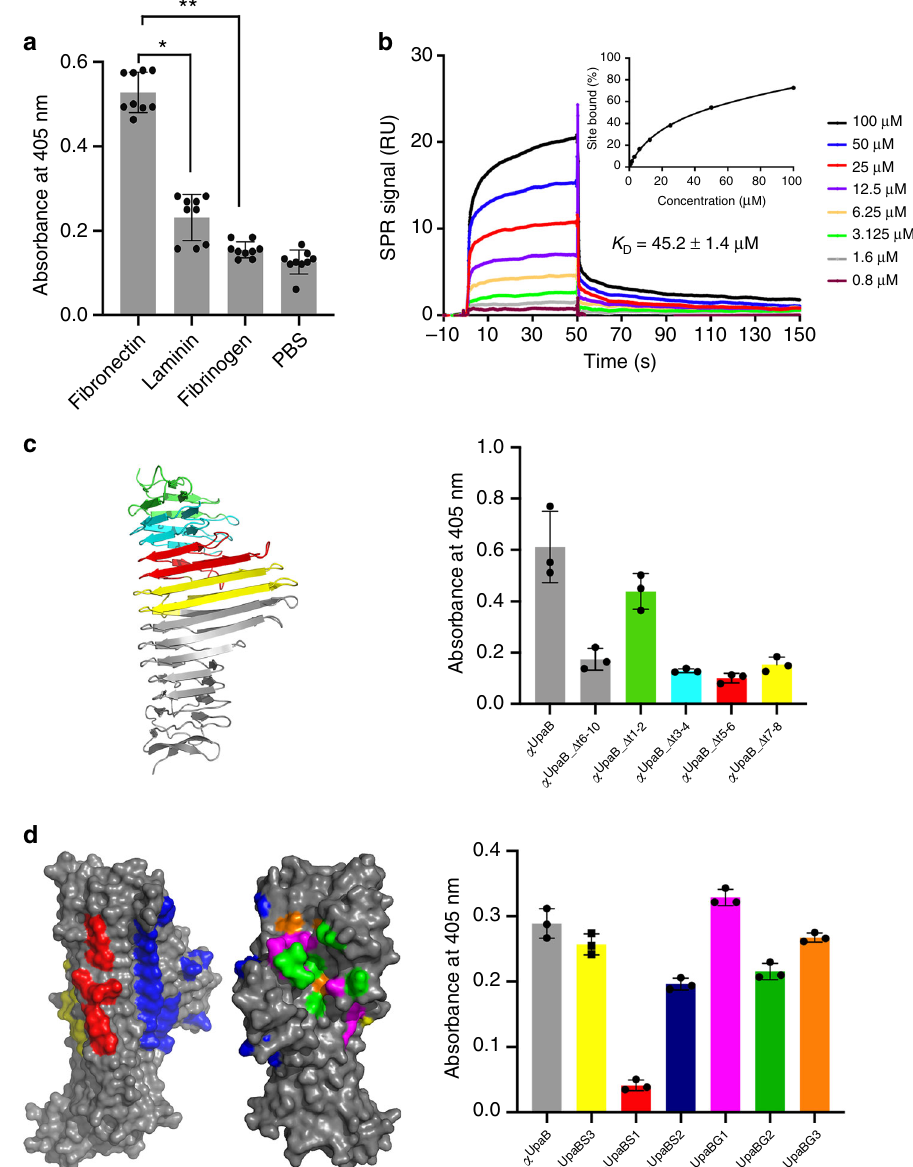
Fig. 3 Functional analysis of the UpaB fi bronectin-binding site. a Assessment of UpaB binding to human fi bronectin, laminin and fi brinogen by enzyme- linked immunosorbent assay (ELISA) using a UpaB-speci fi c polyclonal antibody. UpaB showed highest af fi nity towards fi bronectin. Statistical signi fi cance was determined by unpaired two-sample t test, * P < 0.001, n = 9; ** P < 0.001, n = 9. b Surface plasmon resonance analysis of α UpaB binding to immobilised fi bronectin. A series of concentrations (0.8 – 100 µ M) of α UpaB , as indicated in the sensogram, were injected over fi bronectin. The apparent equilibrium dissociation constant K D was determined using a steady-state af fi nity model. The data are expressed as mean ± standard error of the mean (SEM) of three replicates. c Assessment of binding to fi bronectin by UpaB deletion mutants; α UpaB- Δ t6 – 10 (grey); α UpaB- Δ t1 – 2 (green), α UpaB- Δ t3 – 4 (cyan), α UpaB- Δ t5 – 6 (red) and α UpaB - Δ t7 – 8 (yellow) using ELISA and a fi bronectin-speci fi c polyclonal antibody. α UpaB (native) was included as control. Data are shown as the means ± standard deviation of three replicates. d Assessment of binding to fi bronectin by UpaB mutants containing targeted amino acid substitutions using ELISA and a fi bronectin-speci fi c polyclonal antibody. Targeted changes were made to various surface features of UpaB including an acidic patch α UpaB_S1 (red; N116A, D119A, N146A, N175A, D217A, K245A, D246A, D281A, R310A and D336A) and polar patch α UpaB_S2 (blue; N110A, K111A, N112A, D142A, N171A, D206A, D208A, N212A, N241A, N274A, N276A, N303A, N305A, K325A, D329A, D331A and D349A) on the F2 face, a hydrophobic patch α UpaB_S3 (yellow; V151A, I221A, V249A, A252G, A253G, Y285A, Y312A and V339A) between the F2 and F3 faces, along with a hydrophobic α UpaB_G2 (green, F101A, Y130A, Y187A, F195A, L201G, L202G, Y260A) and acidic patch α UpaB_G3 (orange, E103A, D138A, E165A, E226A) within the GAG binding groove. Binding to fi bronectin by α UpaB_G1 (E165A, N189A, Q197A, N200A, Q203A, K256A and N316A) was also tested. Alteration of the surface acidic patch S1 abolished the ability of UpaB to bind fi bronectin. Data are shown as the mean ± standard deviation of three